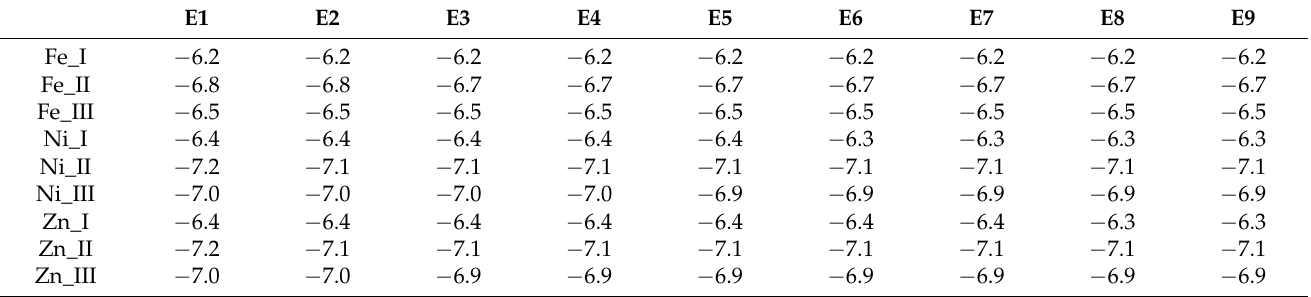
Table 16. Binding affinity for metal-phthalocyanines with C 52 for nine conformations (kcal/mol).